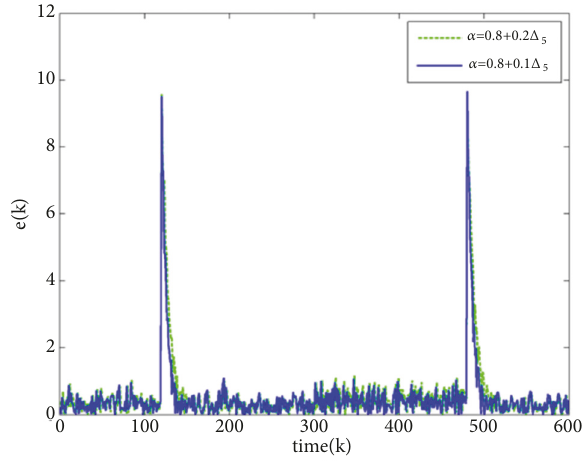
Figure 7: Output error under random-varying